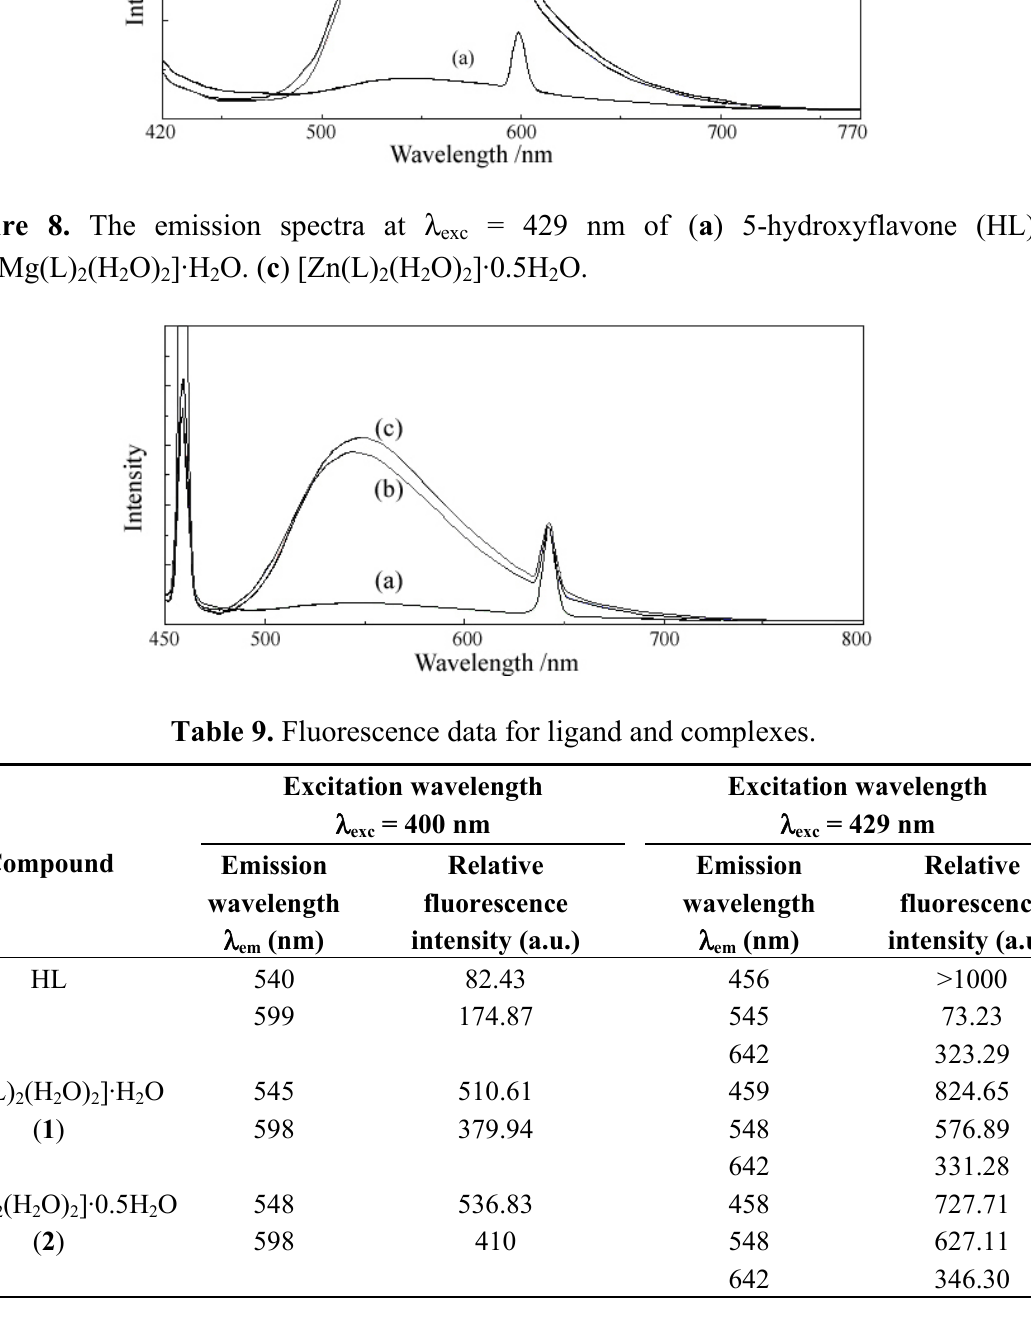
= 400 nm of ( a ) 5-hydroxyflavone (HL). exc